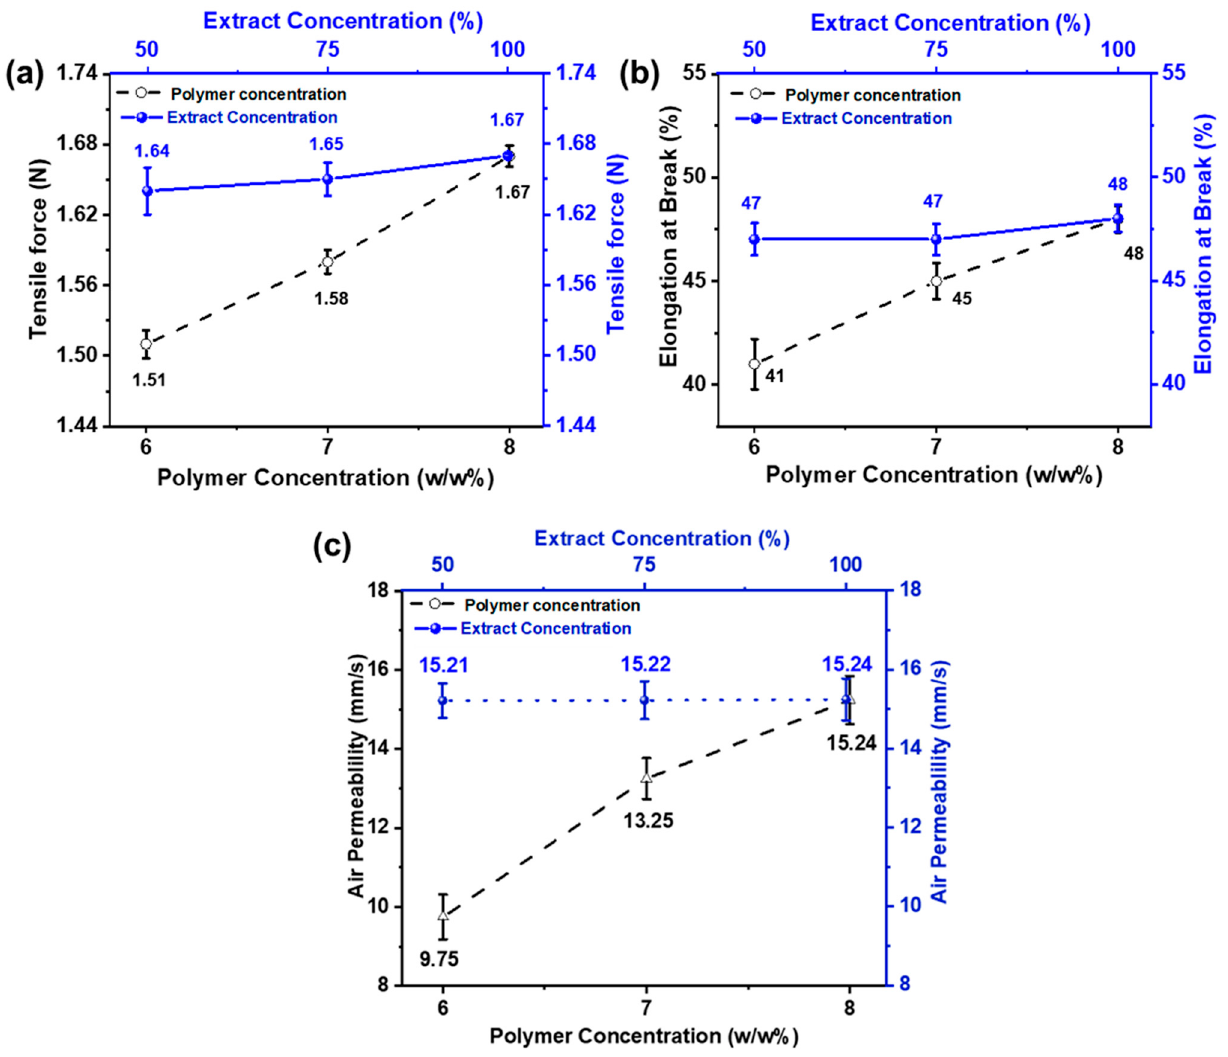
Figure 5. Effect of PVA wt./wt.% (6, 7, and 8 wt% with constant AI /water ratio 100:0) and AI concentrations (50, 75, and 100% with constant 8 wt% PVA ( a ) on tensile force ( b ) elongation at break ( c ) air permeability.